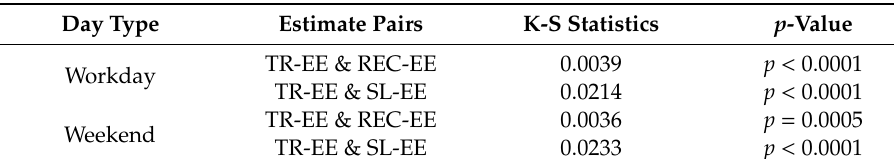
Table 4. K-S test results. Day type